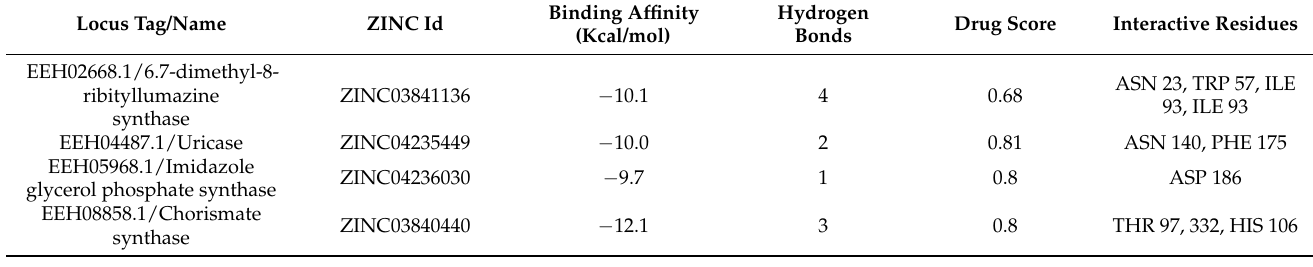
Table 5. Result of the molecular docking for each drug target identified with its respective compounds, binding affinity, hydrogen bonds, drug score and interaction with residues of the active site.